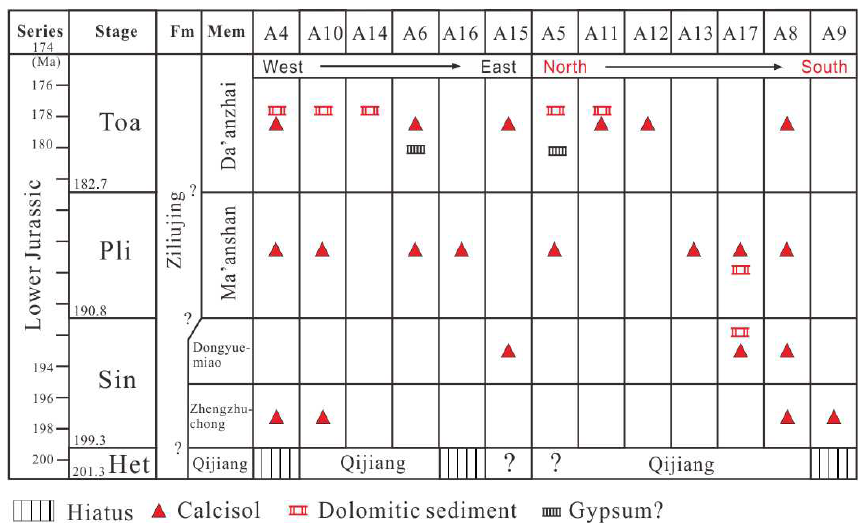
Figure 4. Diagram showing the temporal and spatial variation of climate-sensitive sediments in GSB. Section locations and data sources refer to Table S1.